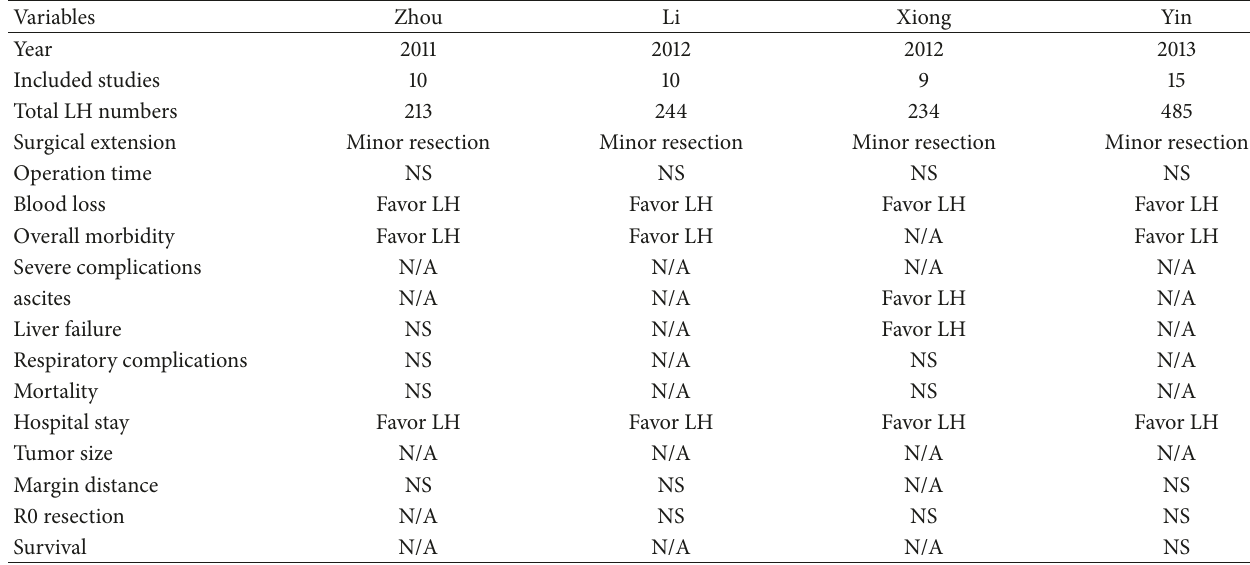
Table 5: Previous meta-analyses comparing LH to OH for HCC.